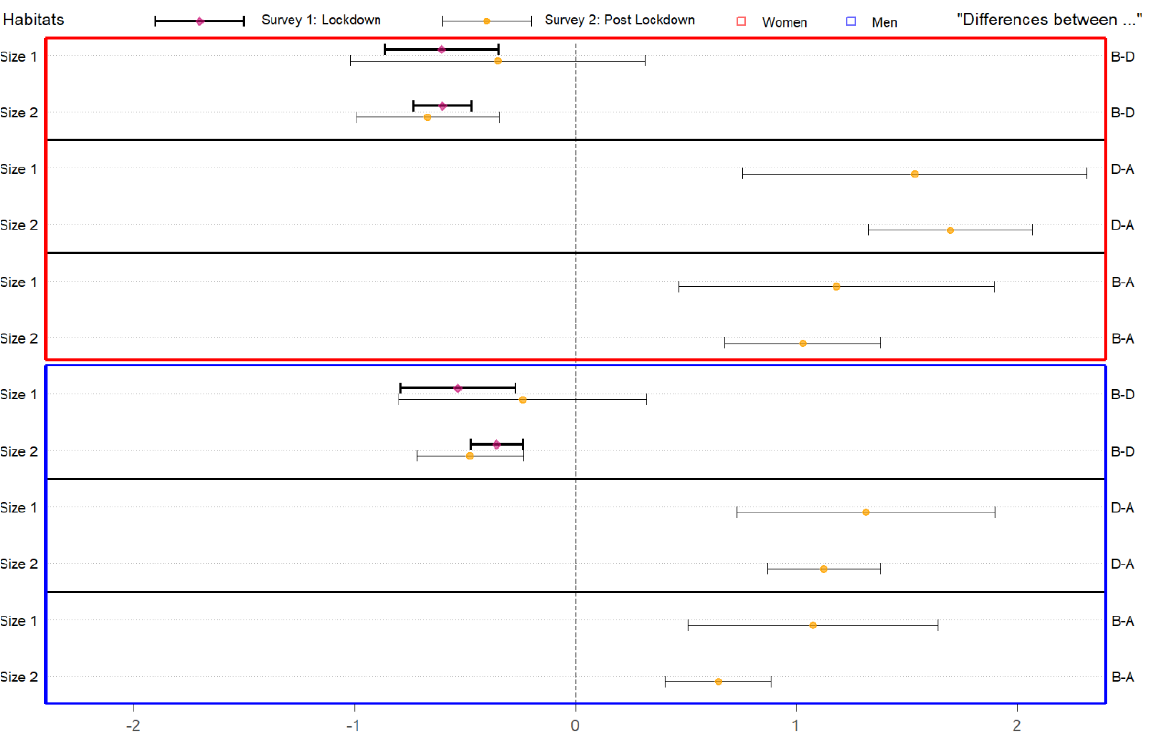
Figure 2. Confidence intervals of mean differences between periods by gender, municipality size and survey. This figure shows the confidence intervals for the mean differences between moments in time with respect to confinement (B: Before, D: During and A: After), differentiating between women and men as well as by municipality size for both surveys. Differences are not significant at 5% level when the corresponding interval intersects with the zero-vertical dotted line. The interested reader can find detailed numbers, including p-values, in Table A1 of Appendix A.